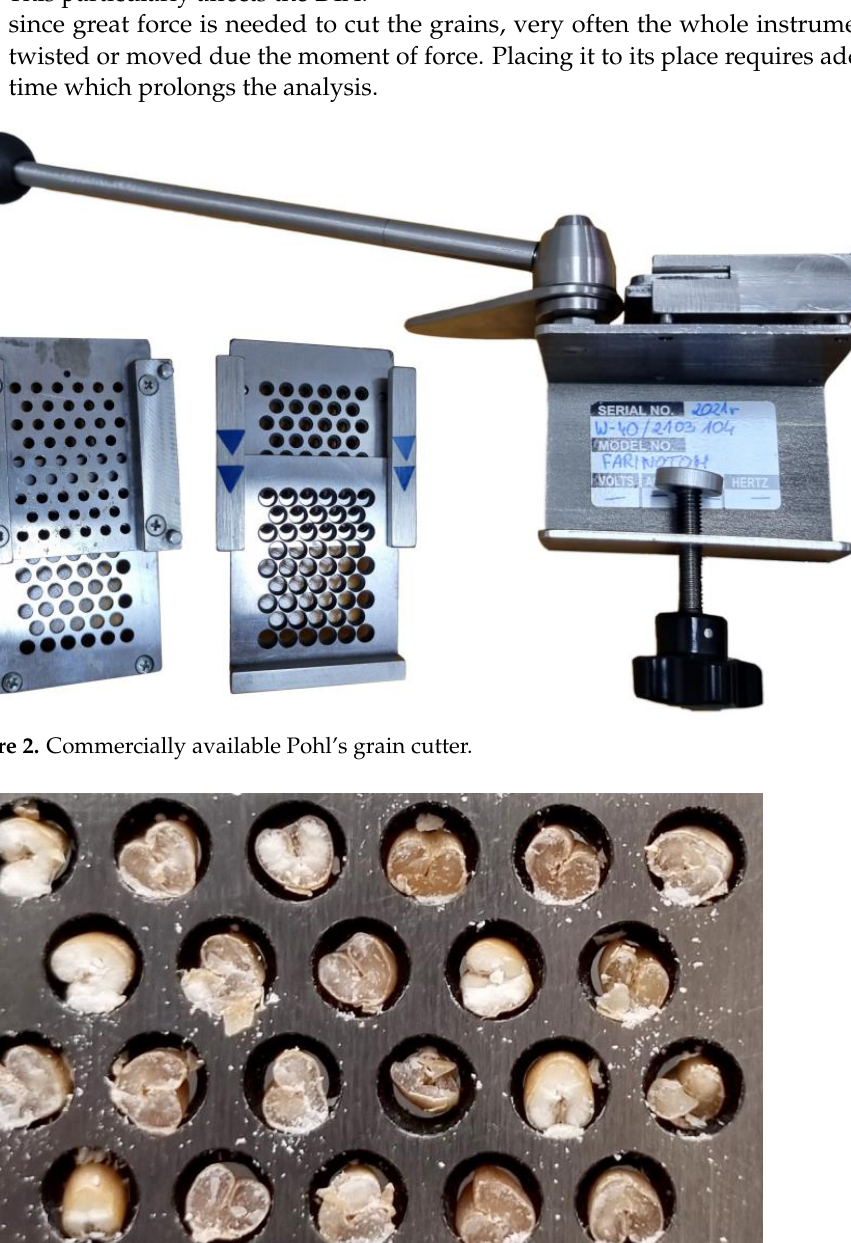
Figure 3. Grain cutter with commercial available Pohl’s grain cutter .